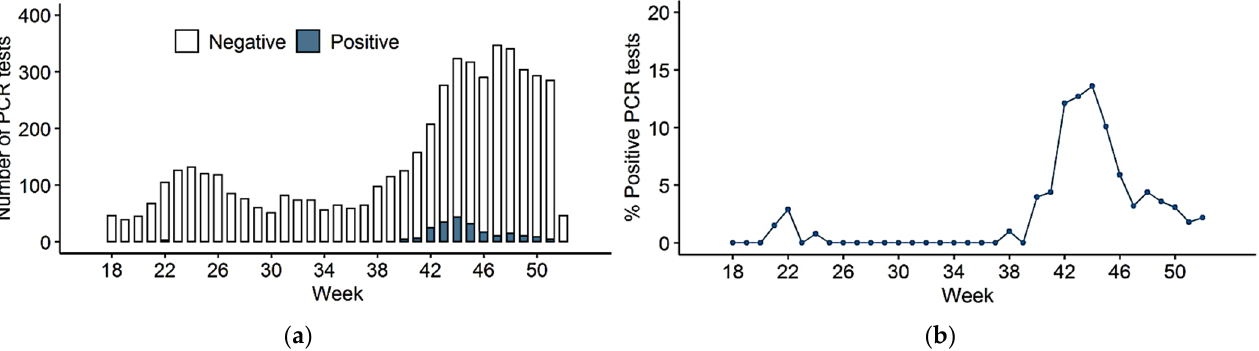
Figure 2. ( a ) Evolution of the number of reverse transcriptase-polymerase chain reaction (RT-PCR) assays performed and their results over time; ( b ) SARS-CoV-2 RT-PCR positive results rates (%) over time. Table 2. Adherence to the study protocol.